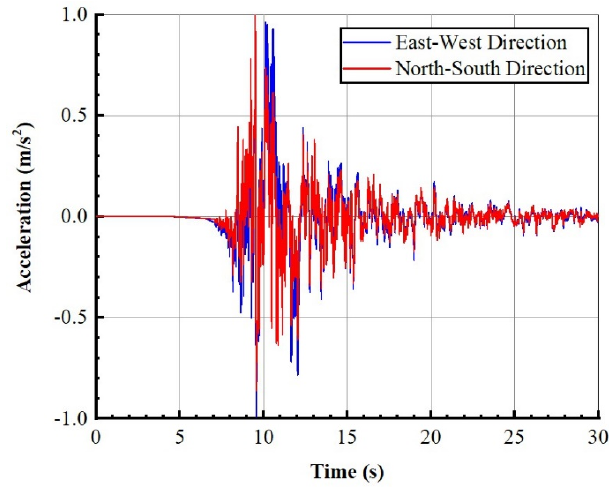
Figure 24. Time-history accelerations in the Sanhe-Pinggu earthquake.